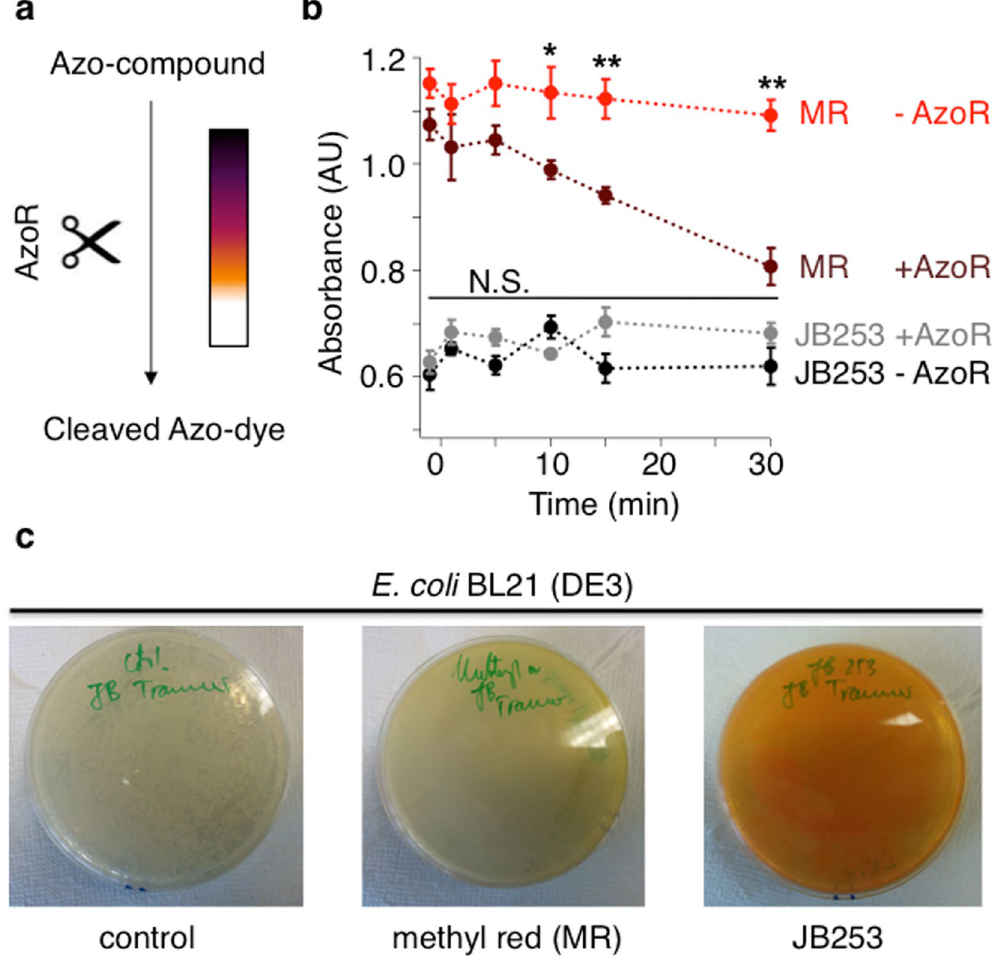
Figure 3. Assessing azo-compound cleavage by azoreductase. ( a ) The bacterial enzyme azoreductase (AzoR) reductively cleaves deeply-colored azo-compounds into corresponding colorless anilines. ( b ) AzoR derived from E. coli BL21 (DE3) is able to cleave the azo-dye Methyl Red (MR; λ = 430 nm), but not the AzoSulfonylurea JB253 ( λ = 450 nm) ( n = 4). ( c ) E. coli BL21 (DE3) on Agar plates after control (left), MR (middle) and JB253 (right) incubation shows that JB253 is still present while MR almost completely disappears; ( n = 4). * P < 0.05, ** P < 0.01 or NS, non-significant, MR or JB253 − AzoR versus MR or JB253 + AzoR; two-way ANOVA (Bonferroni’s multiple comparison test). Values represent mean ±